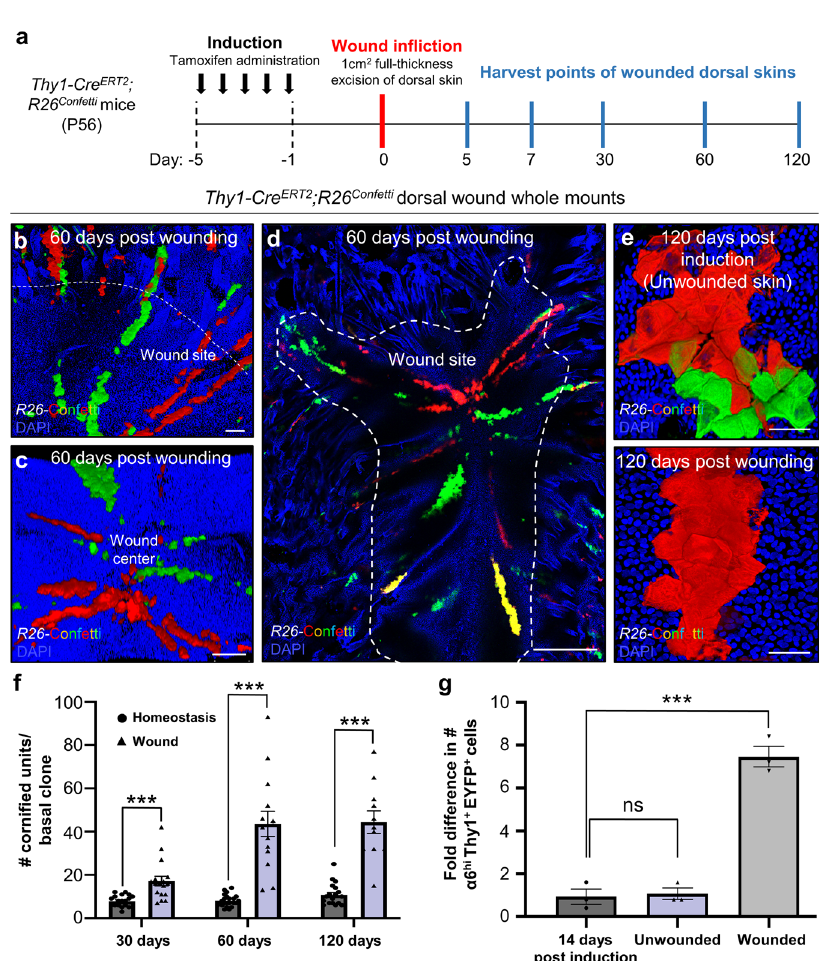
Fig. 5 Thy1 + stem cells are critical for proper wound repair of the skin. a Schematic of induction and wounding. b – d Thy1 + cell progeny migrate to the wound in a clonal fashion and can be detected at day 60 post wound in fl iction within the wound site [ n = 3 mice]. e At 120 days post wounding, clonal units can be detected in the neo-epidermis that deviate from the regular epidermal proliferative unit (EPU) structure [ n = 3 mice]. f Mean number of corni fi ed units per basal clone at 30, 60, and 120 days post induction in homeostatic (unwounded) skin and wound areas [ n = 3 mice per time point, 30 clones per mouse]. g Fold difference in number of EYFP-labeled α 6 hi Sca1 hi Thy1 hi SCs following a 14-day chase post induction (0 days), and after 14 days in wounded or unwounded dorsal skin [ n = 3 mice per group]. ns ( P = 0.778) and *** P = 0.0004 (two-tailed unpaired Student ’ s t test). All error bars show ±S.E.M. All source data are provided as a Source Data fi le. Scale bars: 200 μ m ( b – d ), 50 μ m ( e